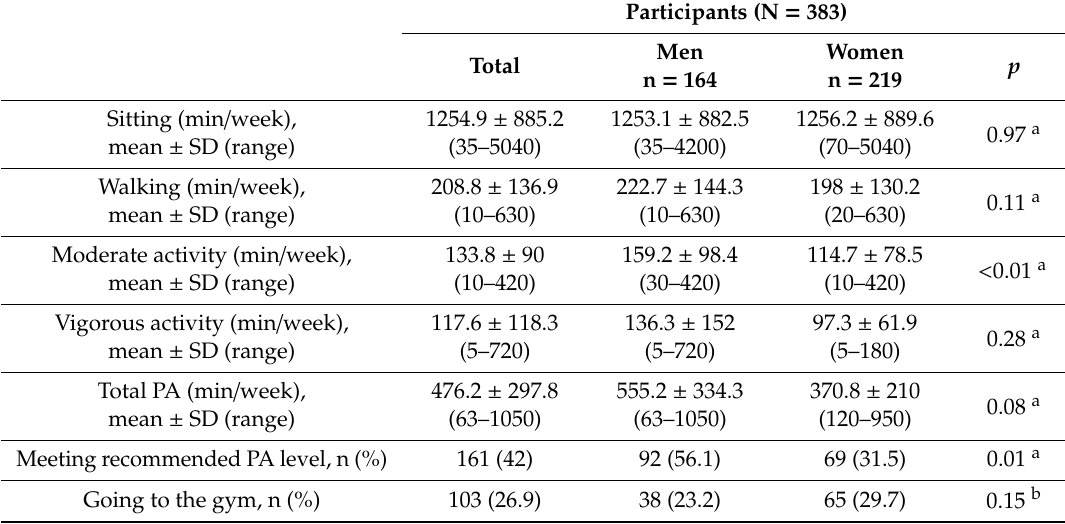
Table 2. Current levels of inactivity and PA reported by participants and p values for the comparison between groups, by